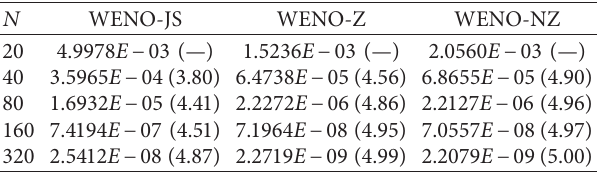
Table 4: L errors and convergence order on Case 2: 1D scalar 1 convection equation with initial condition (60).